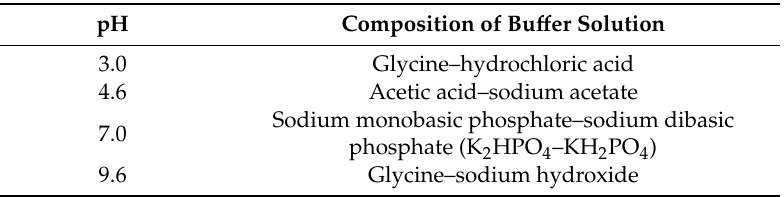
Table 2. Composition of bu ff er